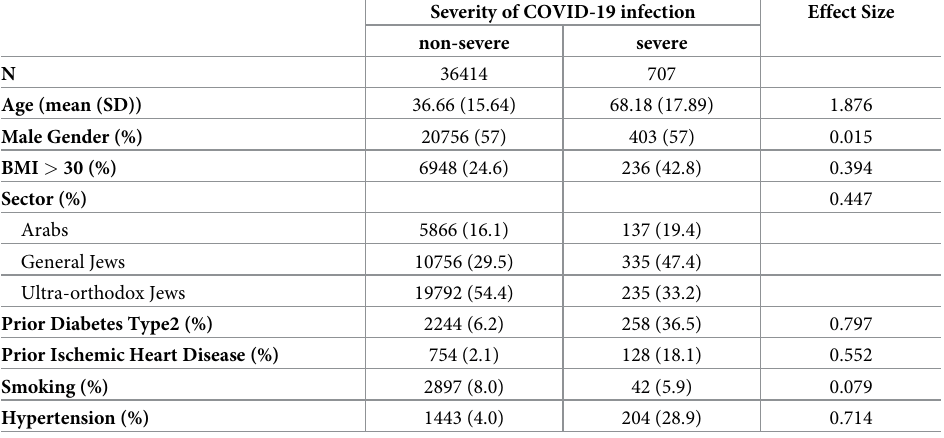
Table 1. Characteristics of patients with severe COVID-19 infection, compared to patients with a non-severe